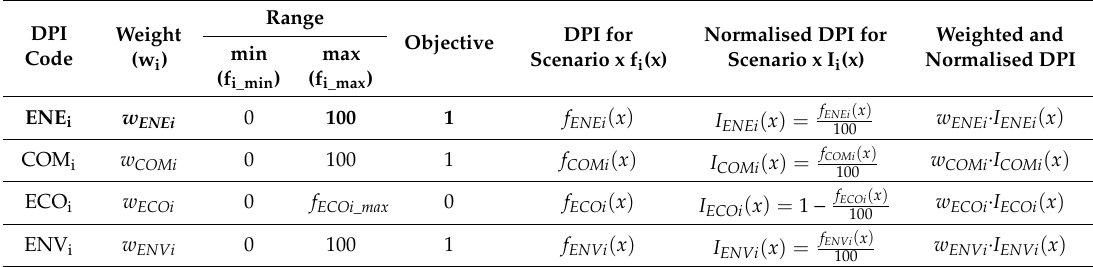
Table 6. Weighting of indicators to build the cost–benefit